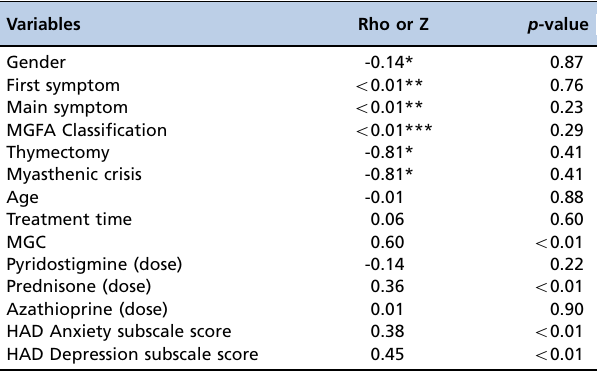
Table 4 - Analyses of the associations and correlations between dependent variables (patient background and clinical factors) and the scores on the Brazilian-Portuguese version of MG-QOL15.